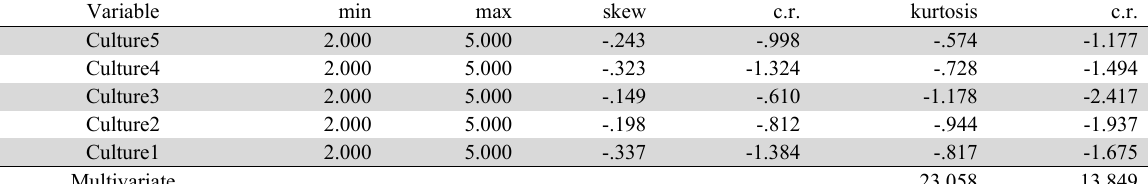
Assessment of normality (Group number 1) Organizational Culture Variables Variable